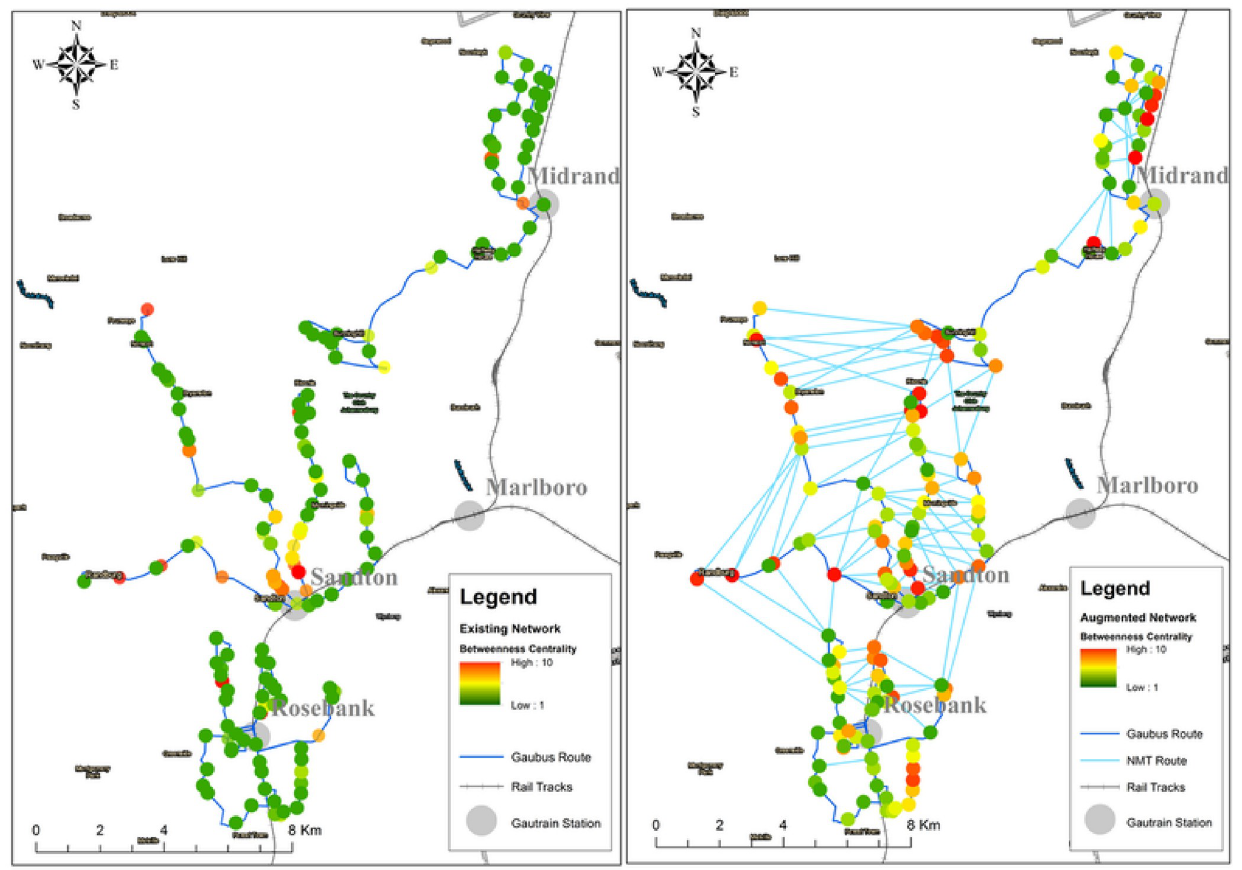
Fig 18. Betweenness centrality: Existing network (left) and augmented network